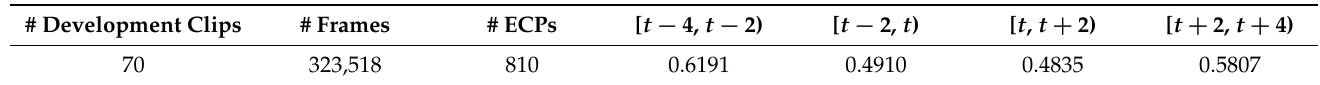
Table 8. The statistics of emotion change points and CPM performances around the emotion change points. # means number of; ECP means Emotional Change